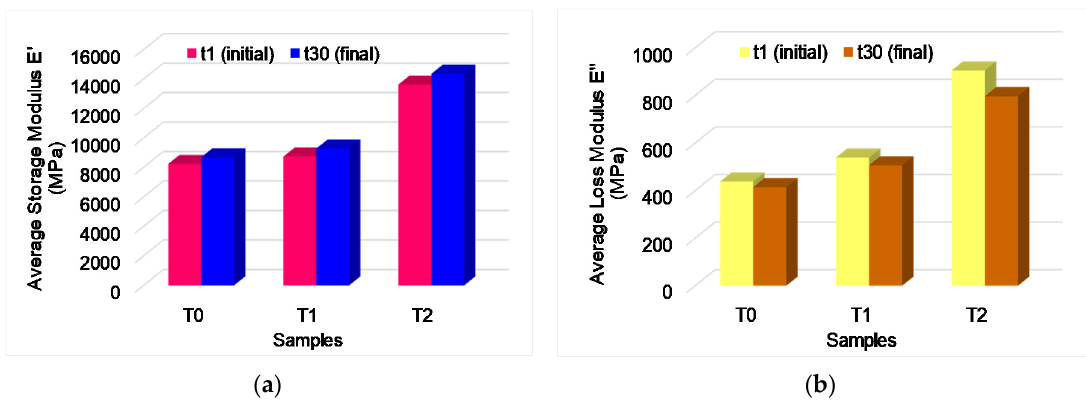
Figure 11. Comparison between dynamic properties of testes samples: ( a ) storage modulus E ’; ( b ) loss modulus E ’’. Polymers 2020 , 12 , 377